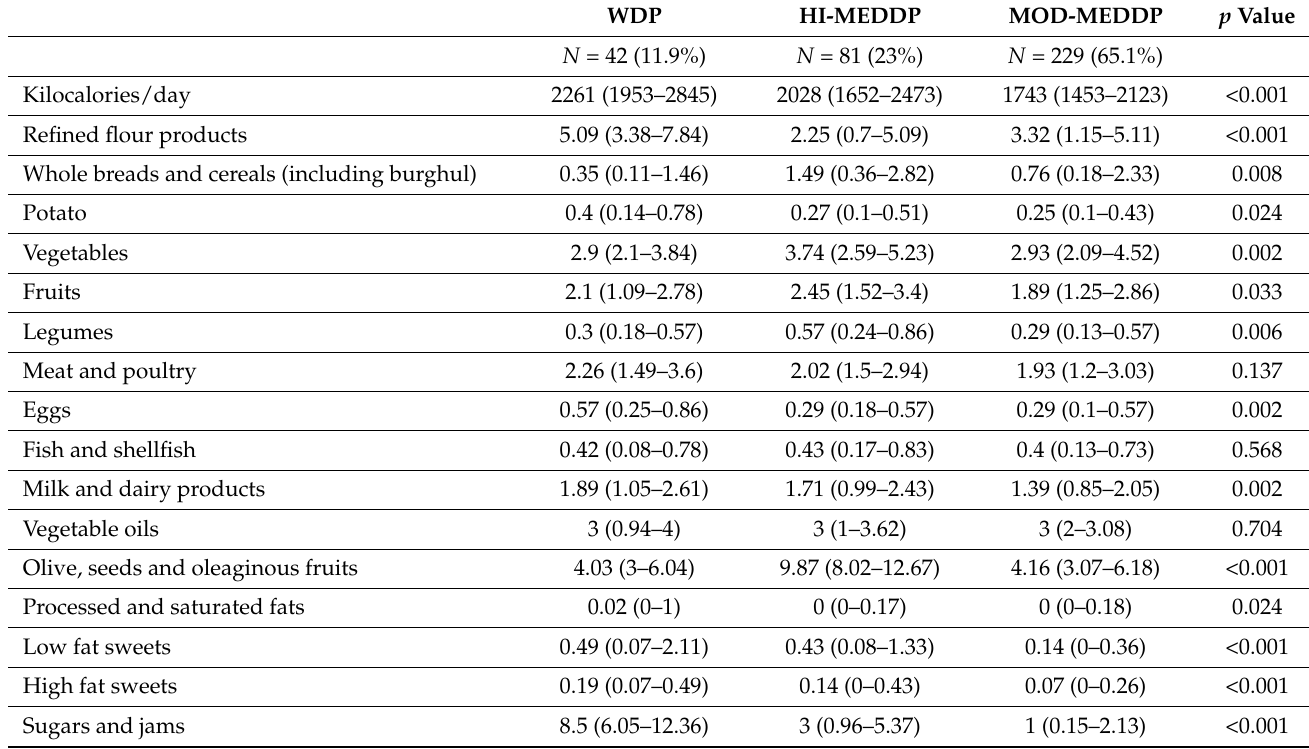
Table 2. Consumption of predefined food categories according to dietary patterns for the overall sample. N = 352.